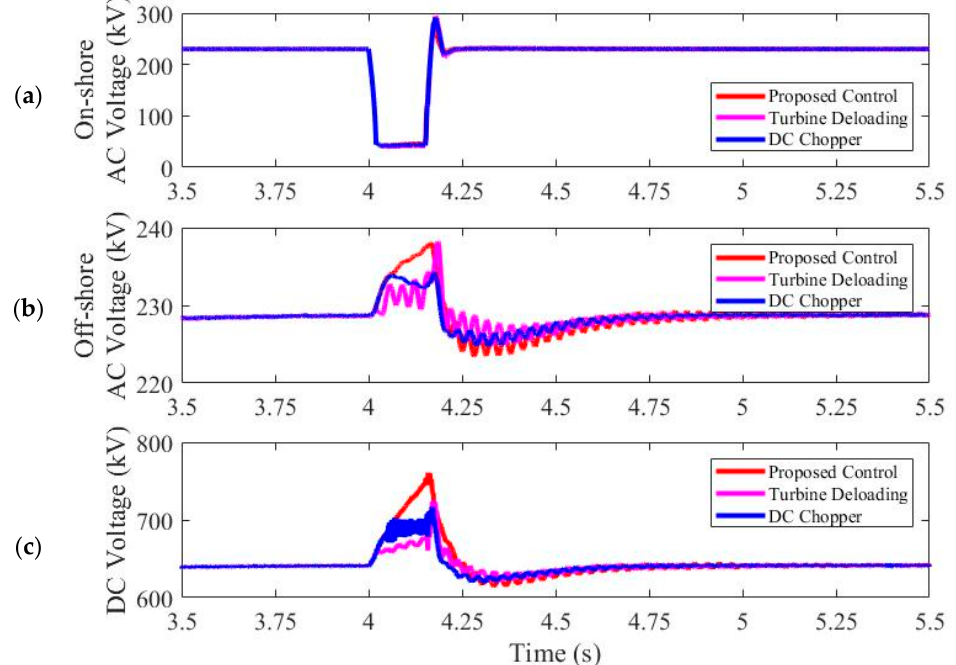
Figure 16. Simulation results of the on-shore fault scenario with a 2.95 Ω fault resistance . ( a ) Off-shore frequency for each simulation case. ( b ) DFIG rotor turbine acceleration for each simulation case. ( c ) Comparison of DFIG the rotor turbine speed by the participation coefficient.